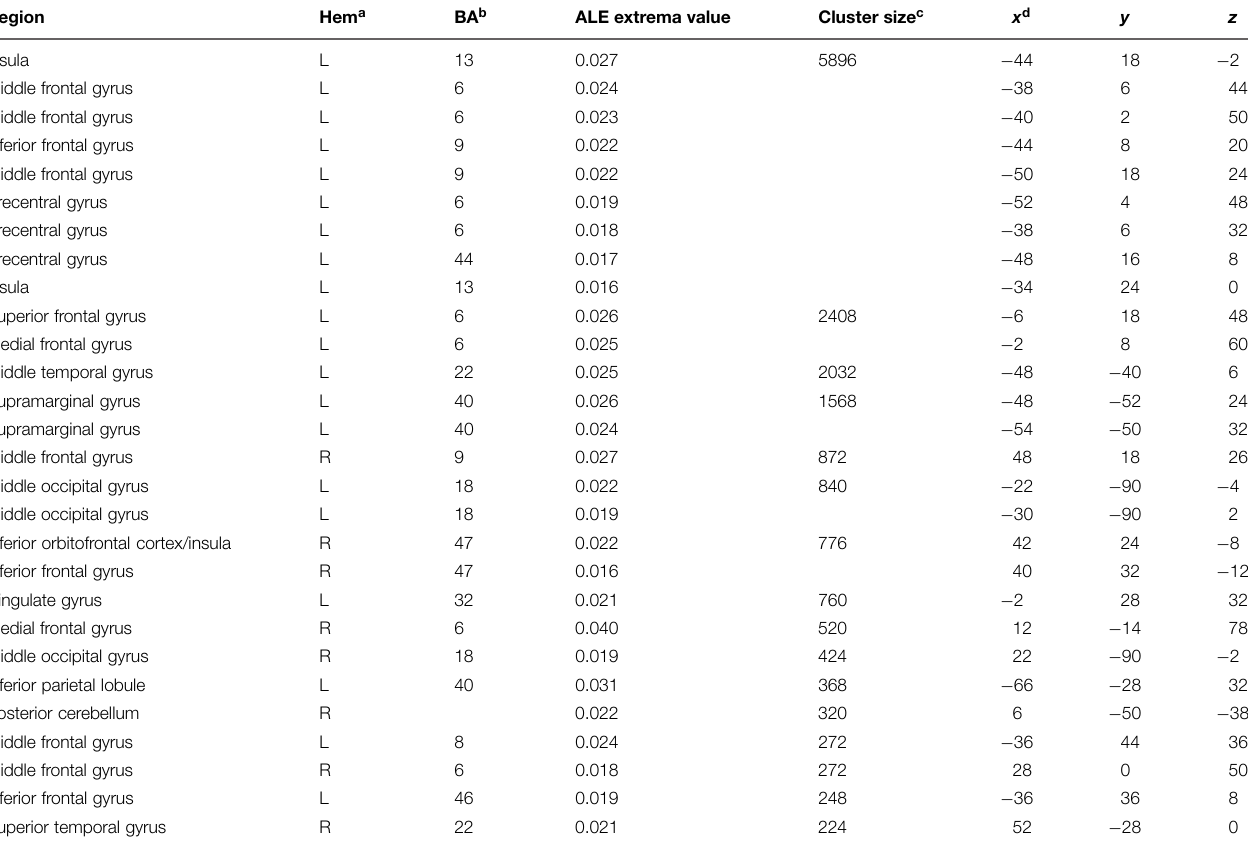
TABLE 2 | Regions showing consistent activations across fMRI studies of creativity, as resulting from the general activation likelihood estimation (ALE) analysis. Region Hem a BA